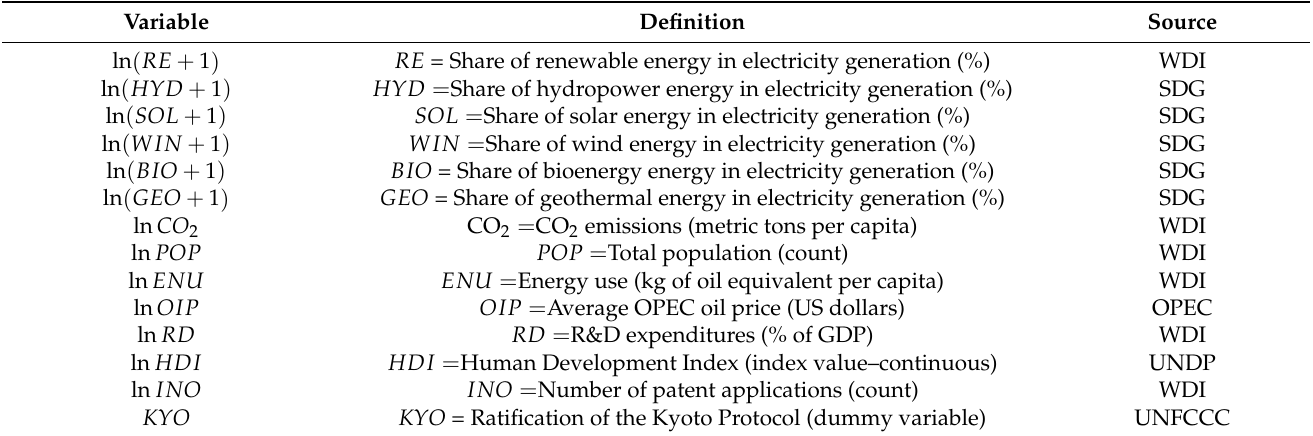
Table 2. Variables definition and data